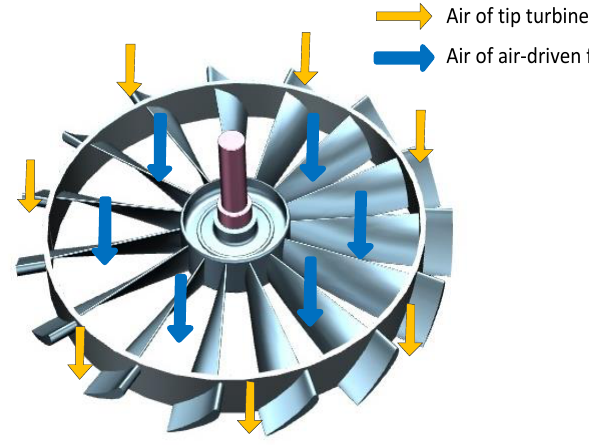
Figure 3. ADFTT rotor.